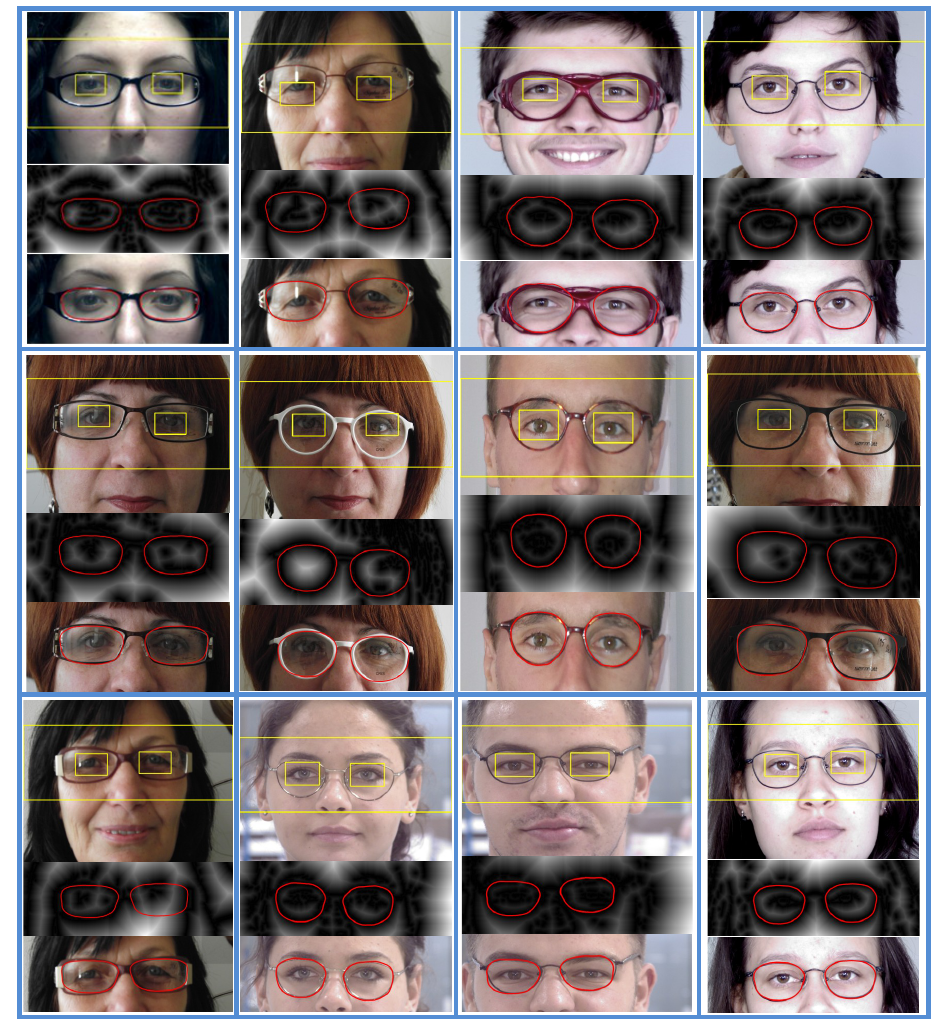
Figure 11. Lens contour extraction